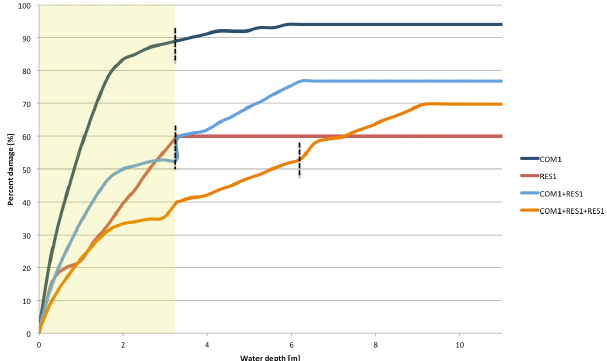
Figure 5. An example of mixed-use curve definition. The light blue curve corresponds to the flood vulnerability function for the content of a two-storey building, with mixed commercial and residential use: specifically retail trade on the ground floor and residential on the first floor. It is obtained by combining the one-storey curve for generic residential (in red) with the one-storey curve for retail trade (in blue). The yellow section of the graph represents the average height of the ground floor. The left part of the mixed curve is ob- tained by re-scaling the blue curve. For higher values of water level, the function increases proportionally to the values that the residen- tial curves assume (red) in the left part of the graph. It is assumed that the value of the ground floor is equal to 60% of the whole (two-storey) building. The orange curve is built in an analogous way, considering a first commercial floor and two upper residen- tial levels, obtained by adding two separate one-storey residential